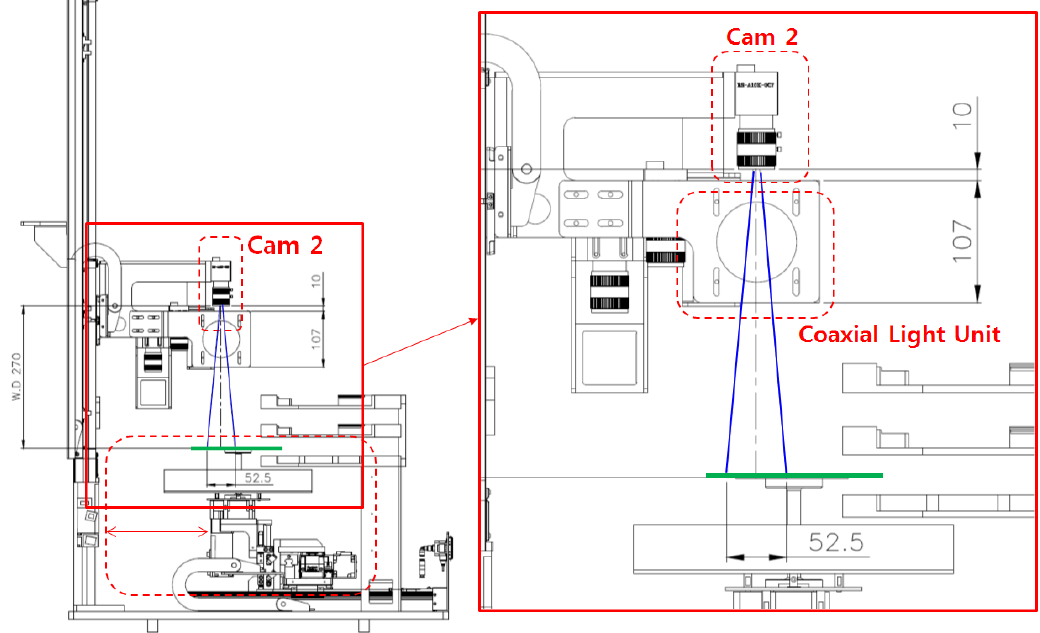
Figure 5. Vision aligner for the detection of wafer flipped.